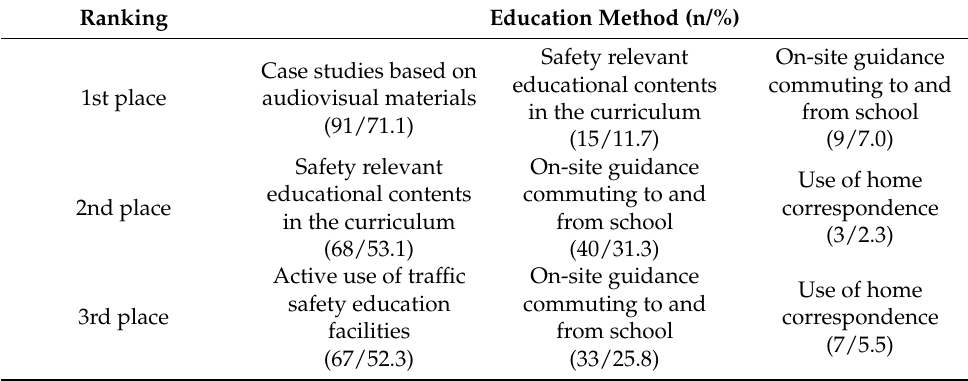
Table 3. Safety education method preference.